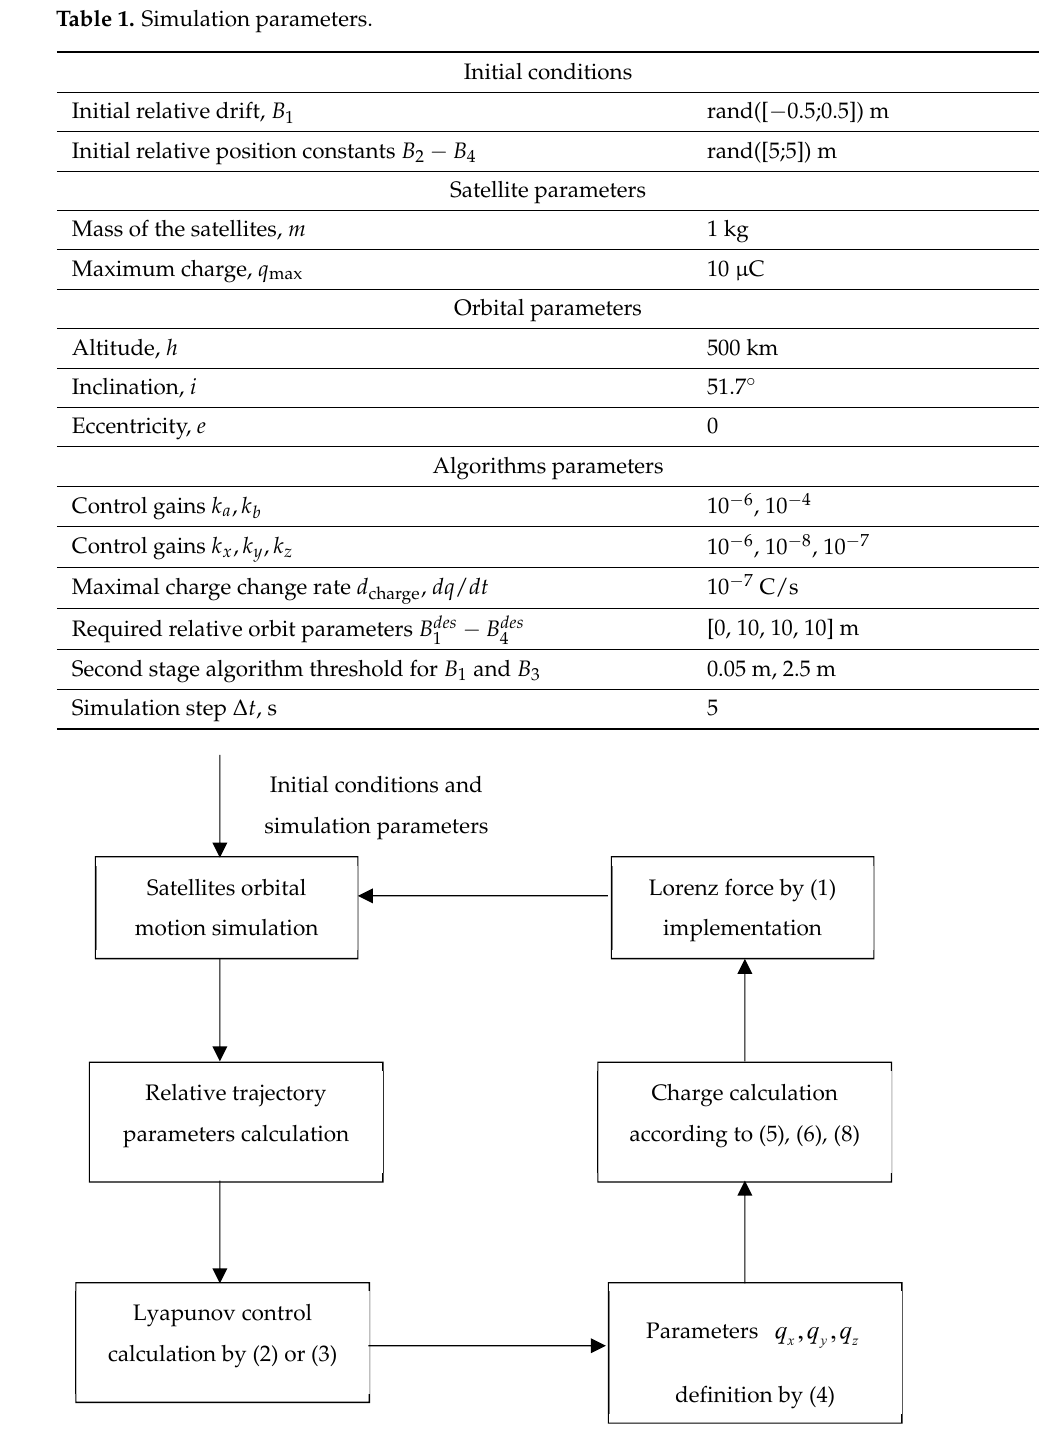
Figure 2. Scheme of controlled motion simulation.